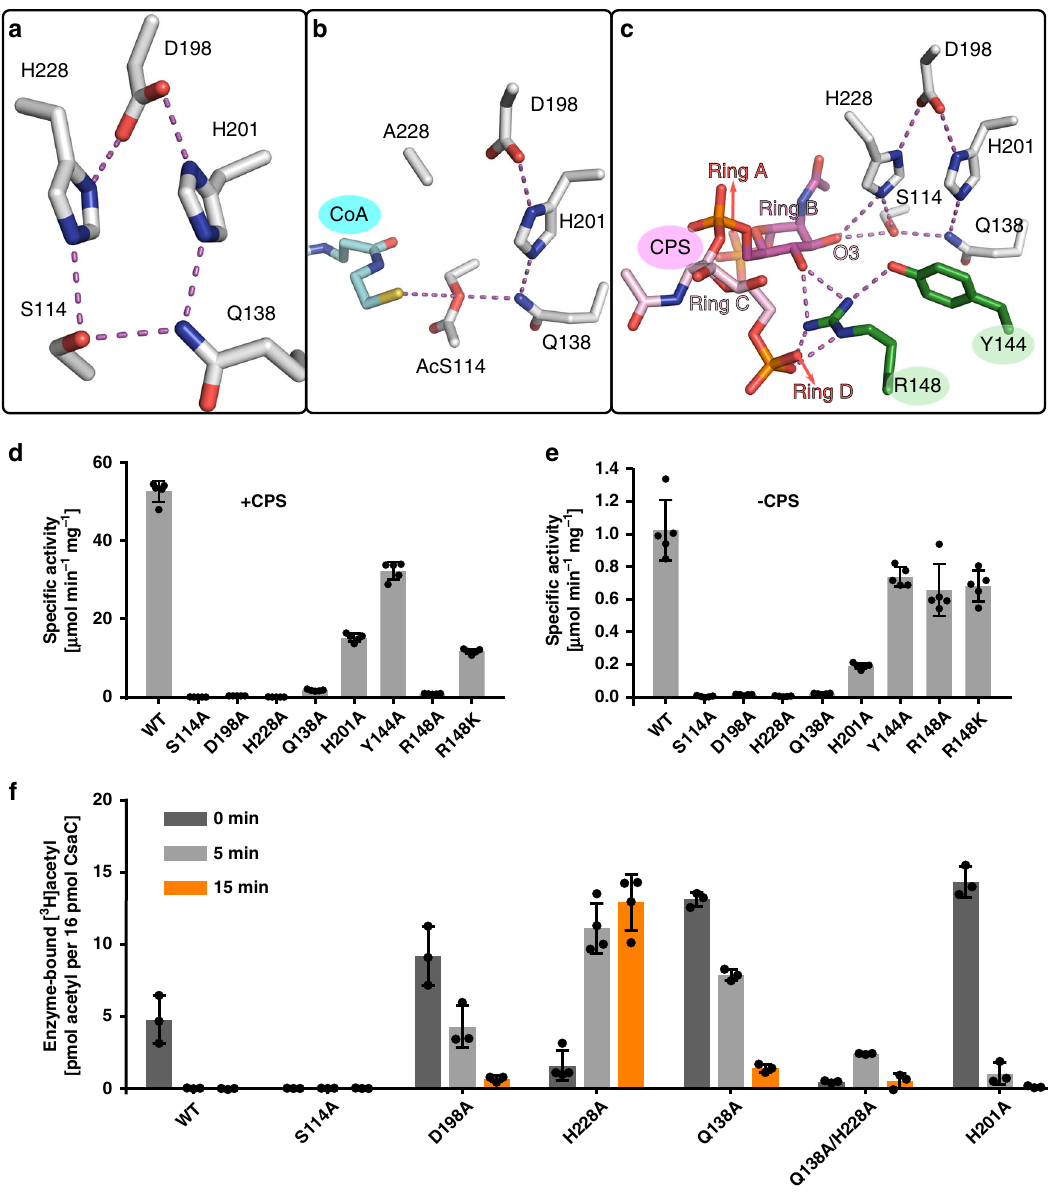
Fig. 5 Active site description of CsaC. a – c Active site residues with hydrogen-bond network (distances ≤ 3.2 Å) for native wild type CsaC a , acetyl-CoA- soaked CsaC-H228A b , and CPS-DP4-soaked wild type CsaC c . d Transferase activity of wild type CsaC and active site mutants in presence of CPS (mean ± SD, n = 5 independent experiments). e Hydrolase activity towards acetyl-CoA measured in the absence of CPS (mean ± SD, n = 5 independent experiments). f Detection of acetyl-enzyme intermediates. Incorporation of radioactively labeled acetyl groups from [ 3 H]acetyl-CoA was measured in the absence of CPS (mean ± SD, n = 4 independent experiments for CsaC-H228A and n = 3 independent experiments for CsaC-WT and all other variants). Source data are provided as a Source Data fi by a hydrogen bond between adenine-N7 and Y49-N, while the phosphate oxygens of the ADP-3 ′ -phosphate moiety are encased by a hydrogen network provided by R237, K53, Y51 and I52 (Fig. 4e and Supplementary Fig. 13).